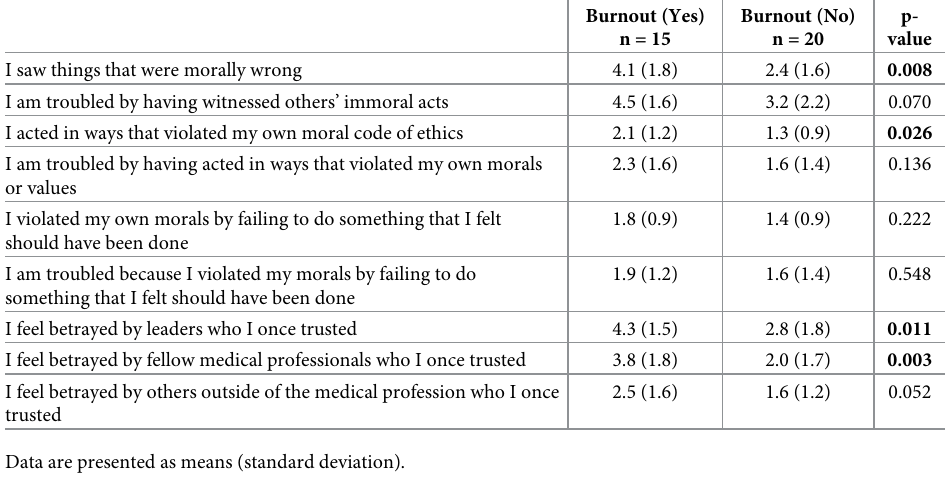
Table 4. Item analysis of the moral injury events scale during COVID-19 comparing hospitalists with and without